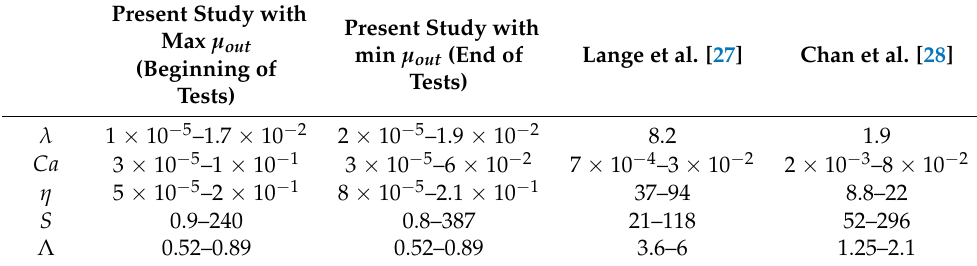
Table 2. Values of dimensionless parameters describing vesicle deformation and dynamics in the present study and in previous studies investigating the effect of shear stress on E. coli (note that the large variation in values is associated with the high variability of cell mechanical parameters). Present Study with Present Study with Max µ out min µ out (End of Lange et al. (Beginning of Tests) Tests)